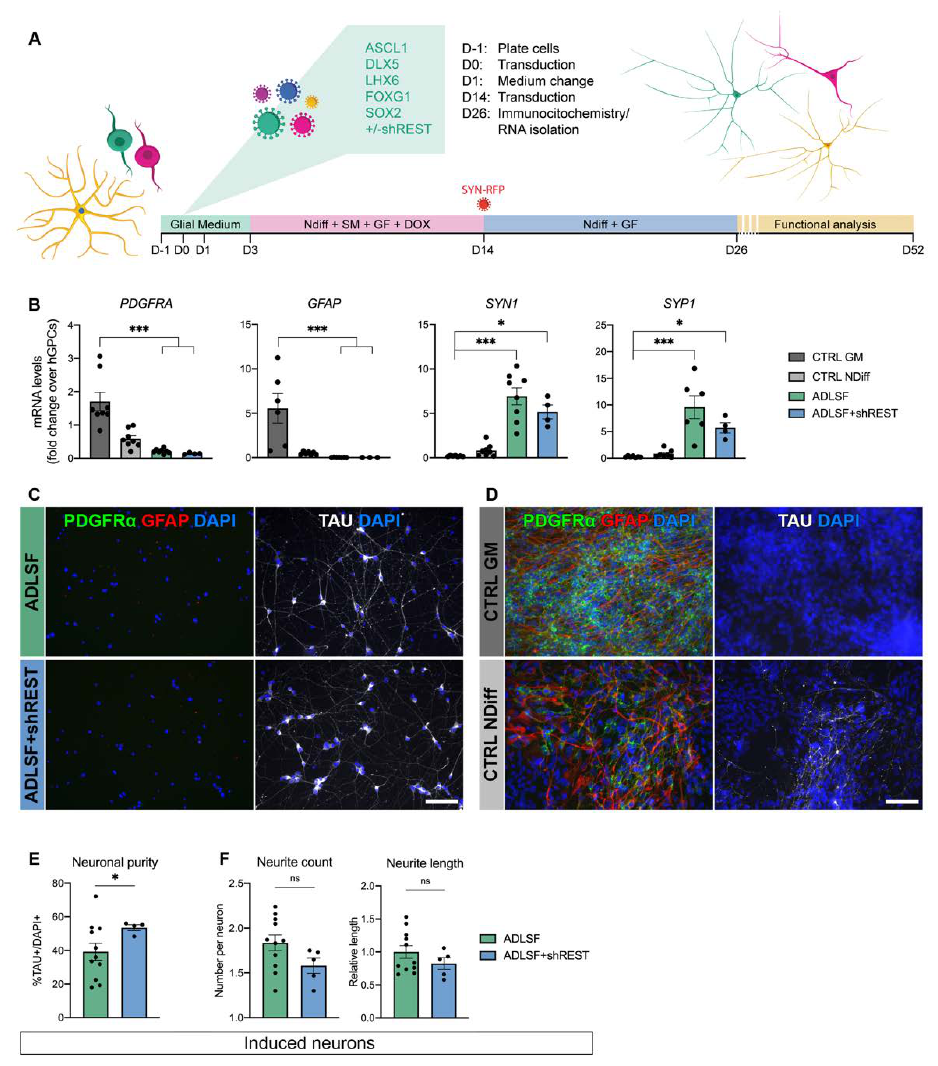
Figure 1. Neuronal conversion of hESC-derived GPCs in 26 days: ( A ) Schematic of the reprogramming strategy using the ADLSF factor combination with or without REST inhibition. ( B ) RT-qPCR analysis showed downregulation of glial markers and upregulation of neuronal genes at day 26 after transduction. Kruskal–Wallis test, Dunn’s multiple comparisons test (n = 6–8 for CTRL GM, n = 7–8 for CTRL NDi ff , n = 6–8 for ADLSF, and n = 3–4 for ADLSF + shREST): *** p < 0.005; * p < 0.05. ( C , D ) PDGFR α / GFAP and TAU immunostainings of ( C ) reprogrammed neurons generated with ADLSF and ADLSF + shREST and ( D ) control glial cells kept in glial medium (CTRL GM) or neuronal conversion medium (CTRL NDi ff ). ( E ) Quantification of immunodetected TAU + cells. Two-tailed unpaired t-test with Welch´s correction